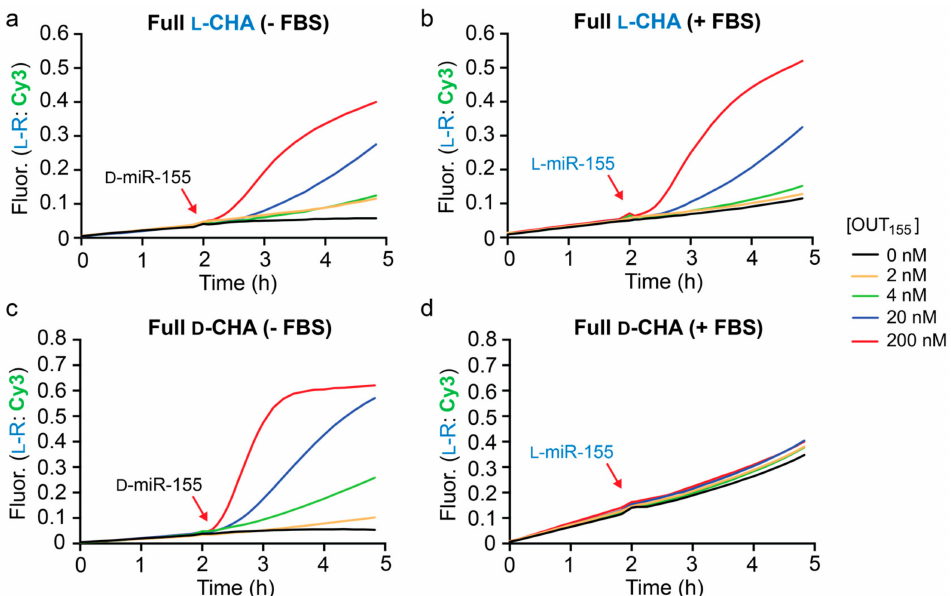
Figure 4. Fluorescence monitoring (Cy3) of the full heterochiral CHA circuit in the absence ( a , c ) and presence ( b , d ) of 10% FBS. Reaction conditions are identical to those described in Figure 3, except that 200 nM inversion gate A 155 was also included. Reactions were initiated with the indicated concentration of either d - or l -miR-155 as indicated and were carried out at 37 ◦ C. Average fluorescence data from triplicate experiments is plotted.